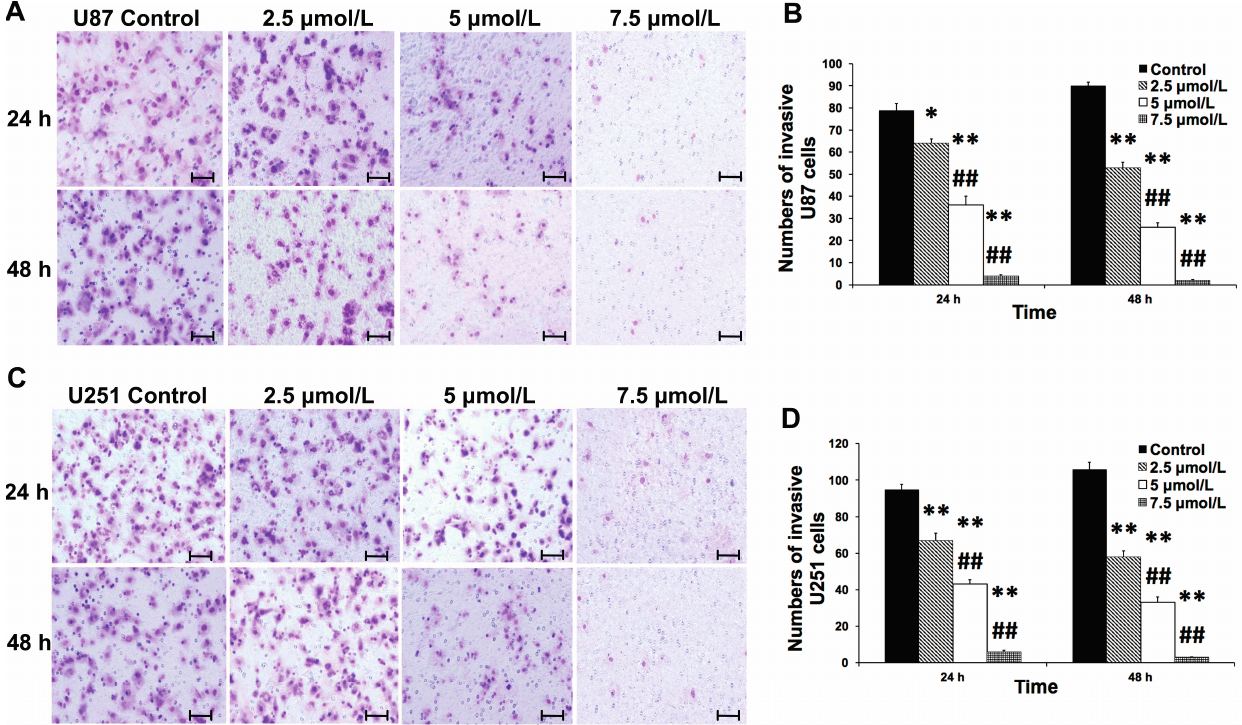
Figure 3. Effects of shikonin on the invasive capacity of glioma cells ( A ) Results of Transwell in vitro invasion assay for U87 cells. In vitro invasion assay was performed to investigate the changes of invasive capacity of U87 cells under the treatment of